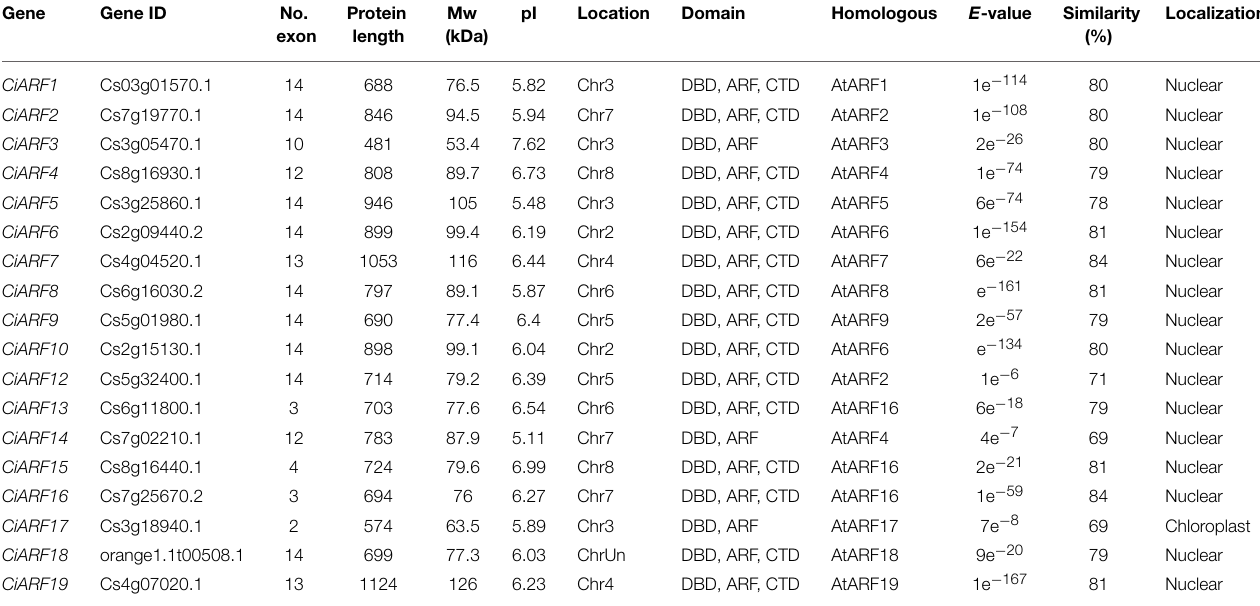
TABLE 1 | CiARF genes encoding ARF proteins along with their molecular